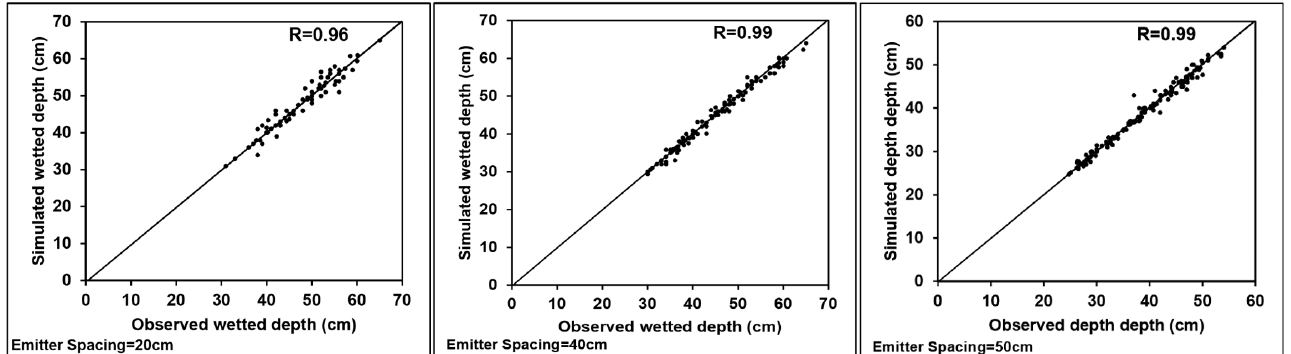
Figure 10. Simulated vs. observed wetted depth obtained at distances of 0, L/4, 3L/4 , and L from the upstream section of the laterals with emitter spacing of 20, 40, and 50 cm.